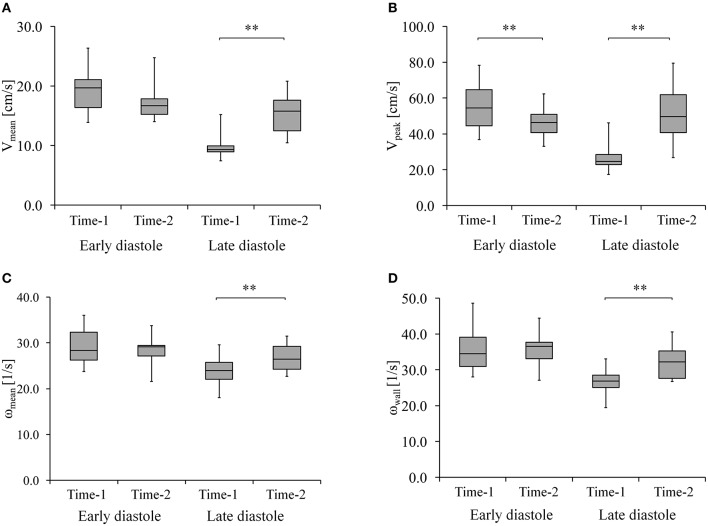
(A) Mean velocity (Vmean) and (B) peak velocity (Vpeak) (C) mean vorticity of LA (ωmean) and (D) near wall vorticity (ωwall) at early and late diastole during Time-1 and Time-2. ** Shows that p < 0.005.